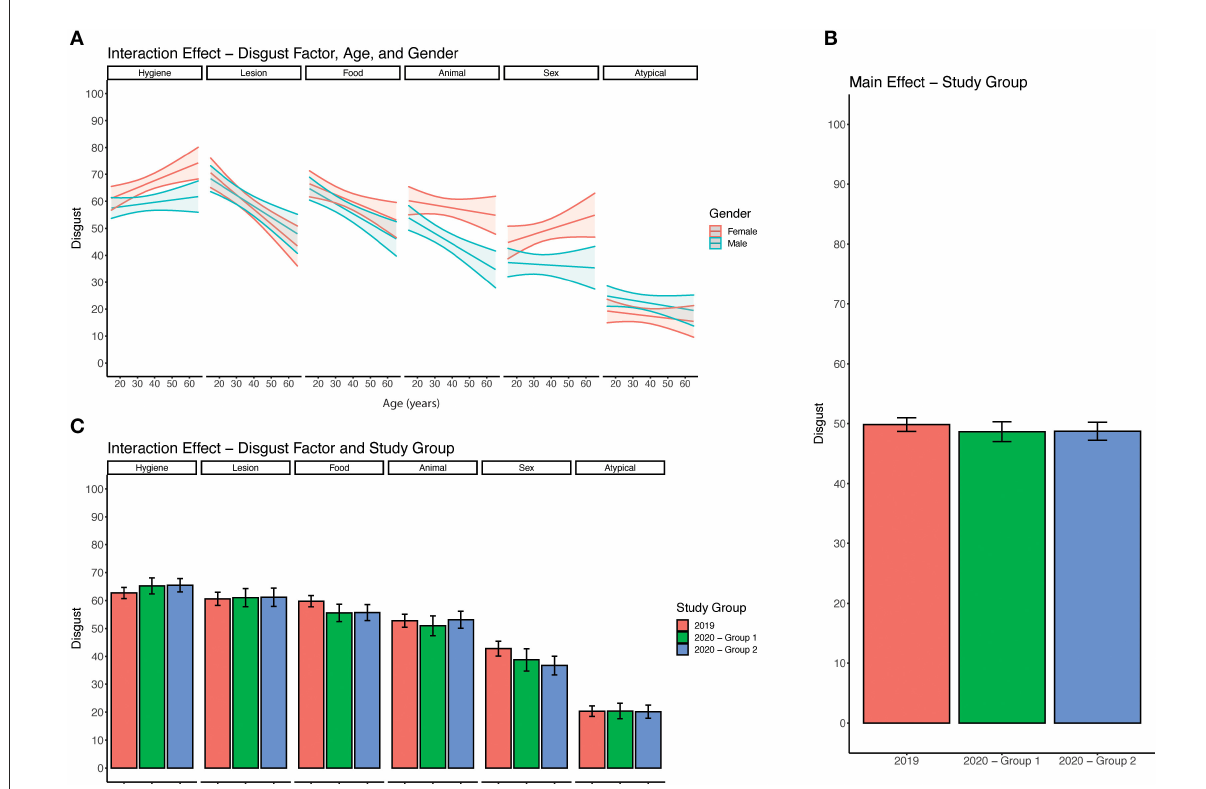
FIGURE1 Analysis of disgust responses. (A) Three-way interaction between age, gender, and disgust factor. For each disgust factor, a pair of lines with a 95% confidence interval (shaded region) indicates average disgust response across age. (B) Average disgust response across all 30 items by study group. 2019 group which refers to the sample collected in 2019. 2020 – Group 1 refers to the subset of responses collected in 2020 that had previously completed the disgust survey. 2020 – Group 2 refers to responses collected in 2020 that had not previously completed the disgust survey. (C) Average disgust response across 6 disgust factors separated by study